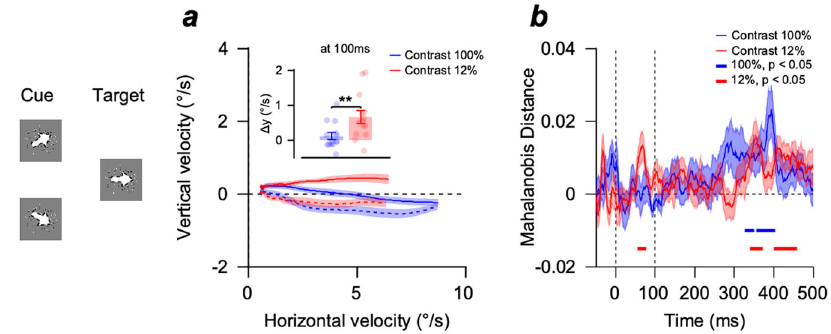
Fig. 3 Effect of experimental control on the eye movement traces and neural representations during central tracking trials. a Average eye velocity traces of central target tracking trials ( (cid:3) 30 (cid:1) ) with an upper directional cue (0 (cid:1) , colored solid lines) and lower directional cue ( (cid:3) 60 (cid:1) , colored dashed lines) rotated by -30 (cid:1) . The bar graphs in the inset show the distance between two eye velocity traces at 100 ms after pursuit latency for 100% (blue) and 12% (red) contrast conditions. The color-shaded areas and error bars show the standard errors. (cid:4) (cid:4) p < 0 : 01, two-sample t -test. The illustration at the left shows motion directions in cue and pursuit targets for calculating eye velocities (Fig. 3a) and EEG dissimilarity (Fig. 3b). b EEG activity pattern dissimilarity between central target tracking trials with upper and lower directional cues. A visual stimulus appeared at 0 ms, and global motion occurred at 100 ms. The blue line (100% contrast) and the red line (12% contrast) at the bottom show the time points where Mahalanobis distance was signi fi cantly different from zero (two-sided cluster-based permutation test, n = 14, cluster-de fi ning threshold p < 0 : 05, corrected signi fi cance level p < 0 : 05, 50000 permutations). The color-shaded areas denote the standard